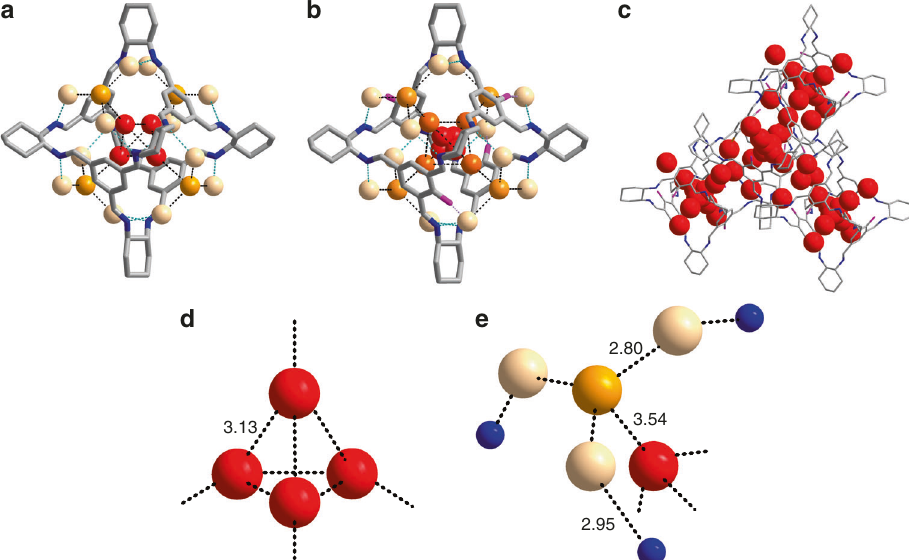
Fig. 3 Water molecule distribution in POCs. Structures of D 2 O in CC3 ( a ) and CC19 ( b ), determined from neutron powder diffraction measurements. Carbon, gray; nitrogen, blue; hydroxyl oxygen, pink. The oxygen atoms from deuterium oxide are presented in balls with various colors (i.e., red, orange, yellow, and light yellow) to indicate crystallographically independent D 2 O species. Deuterium and hydrogen atoms are omitted for clarity. c Arrangement of oxygen atoms (red) of D 2 O in four closely packed CC19 molecules. Peripheral oxygen atoms are omitted for clarity. Crystallographic arrangement of D 2 O in the internal cavity ( d ) and inter-POC space ( e ) of CC3 with possible hydrogen bonding between the D 2 O molecules and the POC. Nitrogen atoms from CC3 are represented as blue spheres. Note that the orientational disorder of D 2 O was expected at room temperature, and the D 2 O molecules were modeled with multiple deuterium